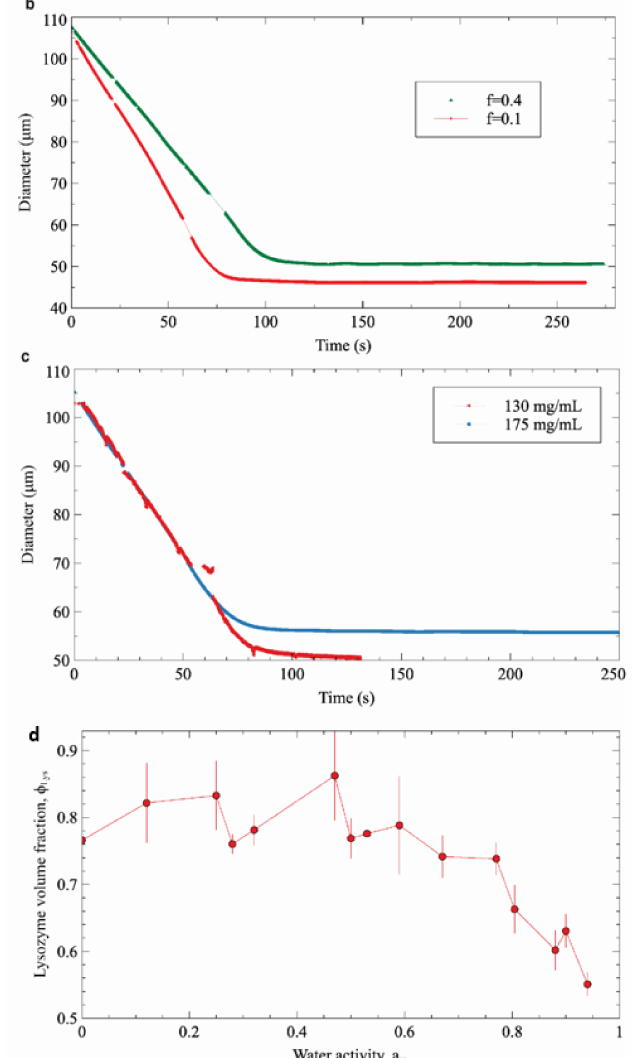
Figure 5. The effect of 3 factors: diameter ( a ), the saturation fraction ( b ),the initial concentration of protein ( c ) to the dehydration process, and ( d ) the final volume fraction of lysozyme as function of water